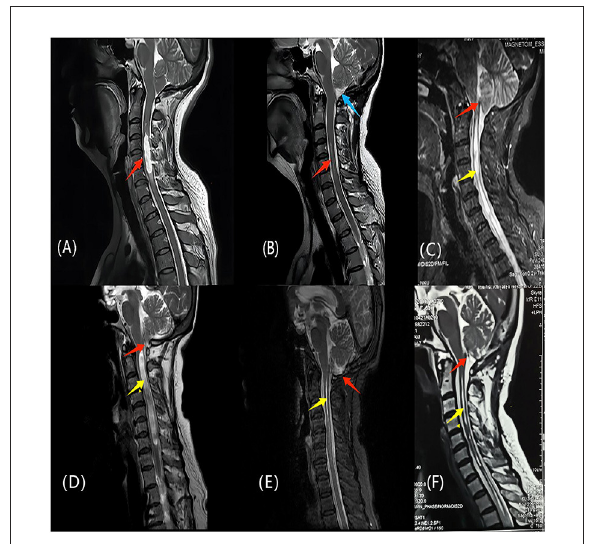
FIGURE2 (A, B) One patient of CM-Iwith syringomyelia underwent PFDRT. (A) The red arrow indicates the syringomyelia before operation; (B) The syrinx indicated by the red arrow almost disappeared, and the blue arrow indicates the indirect increase of the cisterna magna after the removal of the cerebellar tonsils. (C, F) another patient of CM-Iwith syringomyelia underwent PFDRT. (C) The red arrow indicates the obstructive state in the Magendie foramen; (F) The red arrow indicates that restricted CSF circulation in the Magendie foramen was improved after operation. The yellow arrows indicate a significant improvement of the syringomyelia. (D, E) The patient of CM-Iwith syringomyelia was treated with PFDD. Red arrows indicates the cerebellar tonsils and the yellow arrows indicates the syringomyelia. (E) Two years later after operation, the cerebellar tonsils returned to be normal and the syrinx almost disappeared. The clinical symptoms of the above three patients